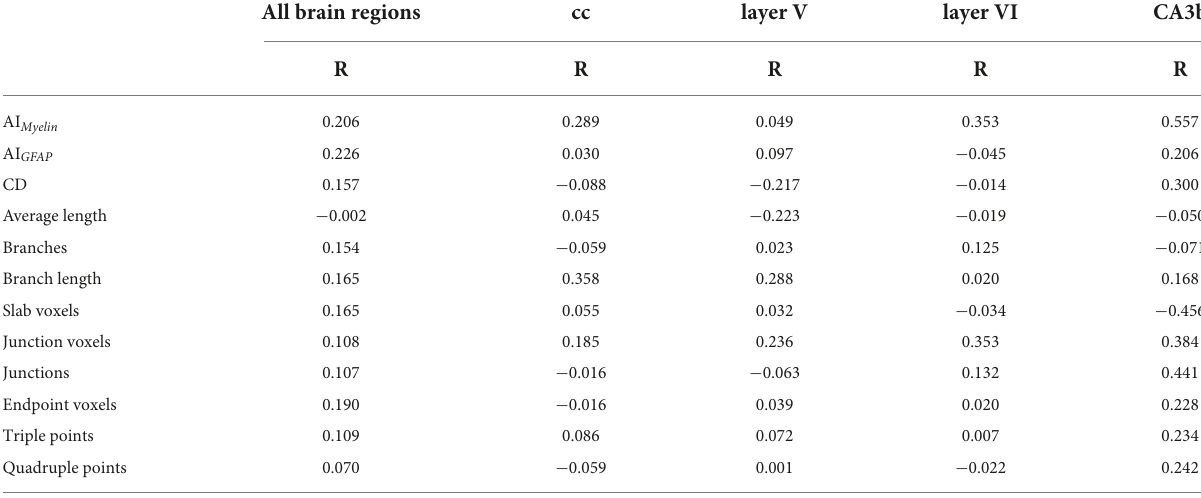
TABLE 5 Leave-one-brain region out cross-validation of multiple linear regression analyses between DTI and histological parameters. All brain